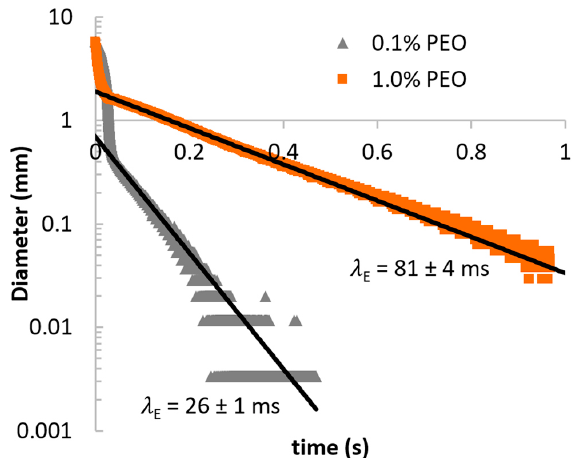
Figure 2. Viscosity plot of test liquids across a wide range of shear rate.